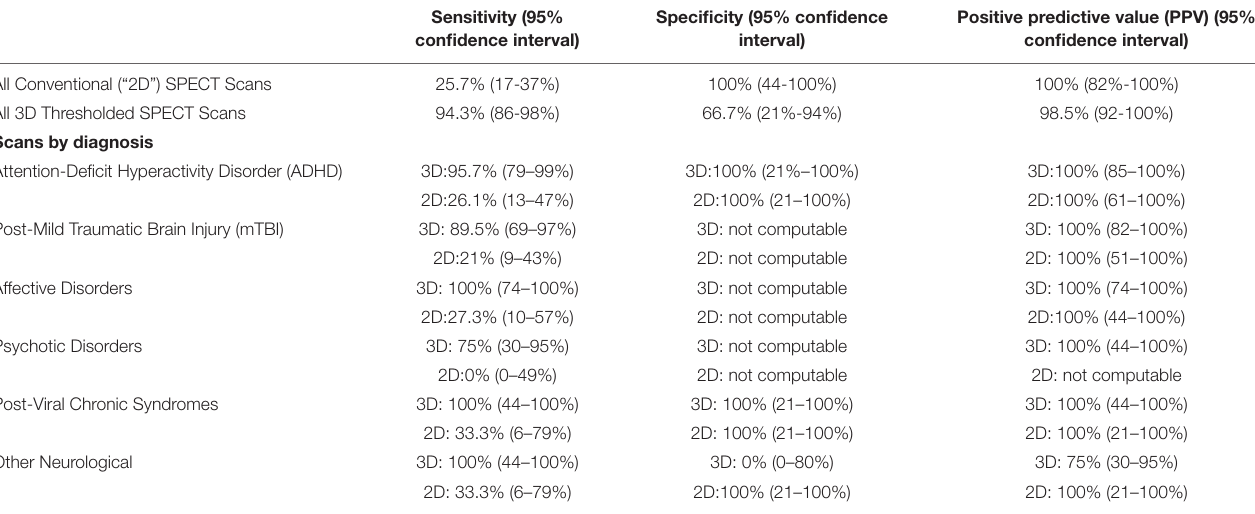
TABLE 2 | Sensitivities, specificities and positive predictive values for conventional (“2D”) brain SPECT and 3D thresholded brain SPECT images in predicting improvement in psychiatric